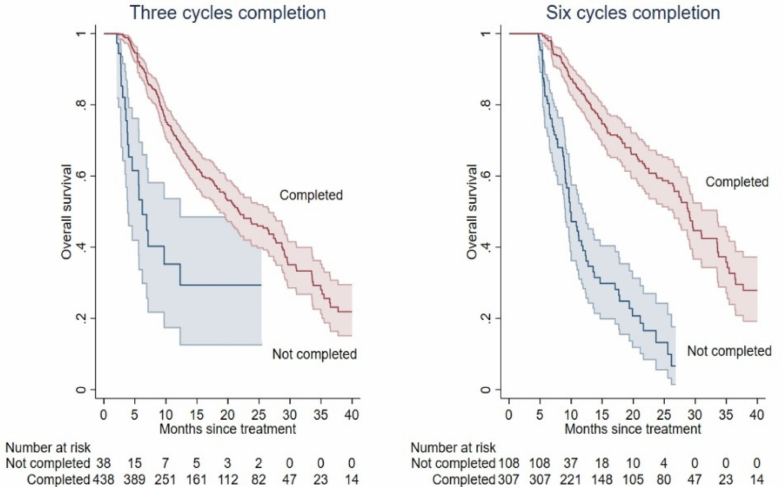
Figure 3. Kaplan-Meier OS curves according to treatment completion. OS prediction according to treatment completion at T3 ( left panel ) and T6 ( right panel ). Completed and incomplete cycles are represented as red and blue colours,